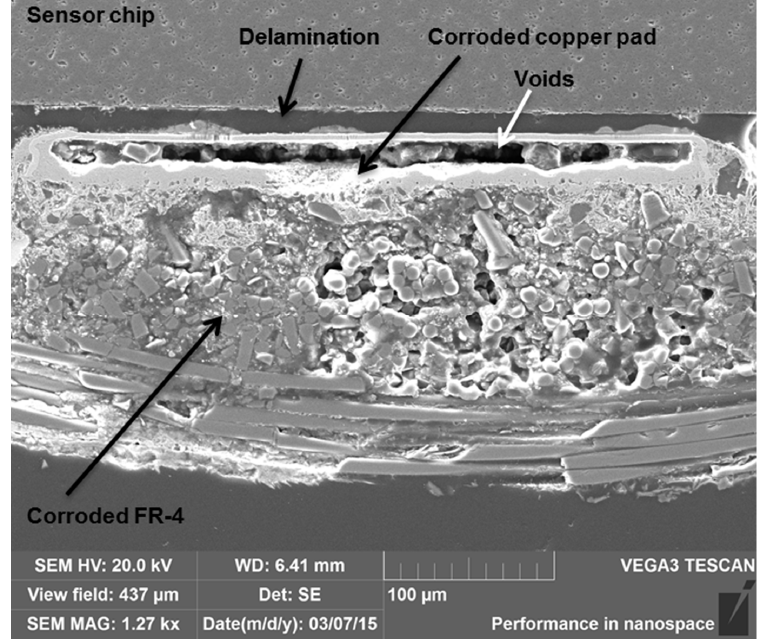
Figure 11. SEM Cross ‐ section of a FR ‐ 4 sample aged for 40 days at 200 °C.